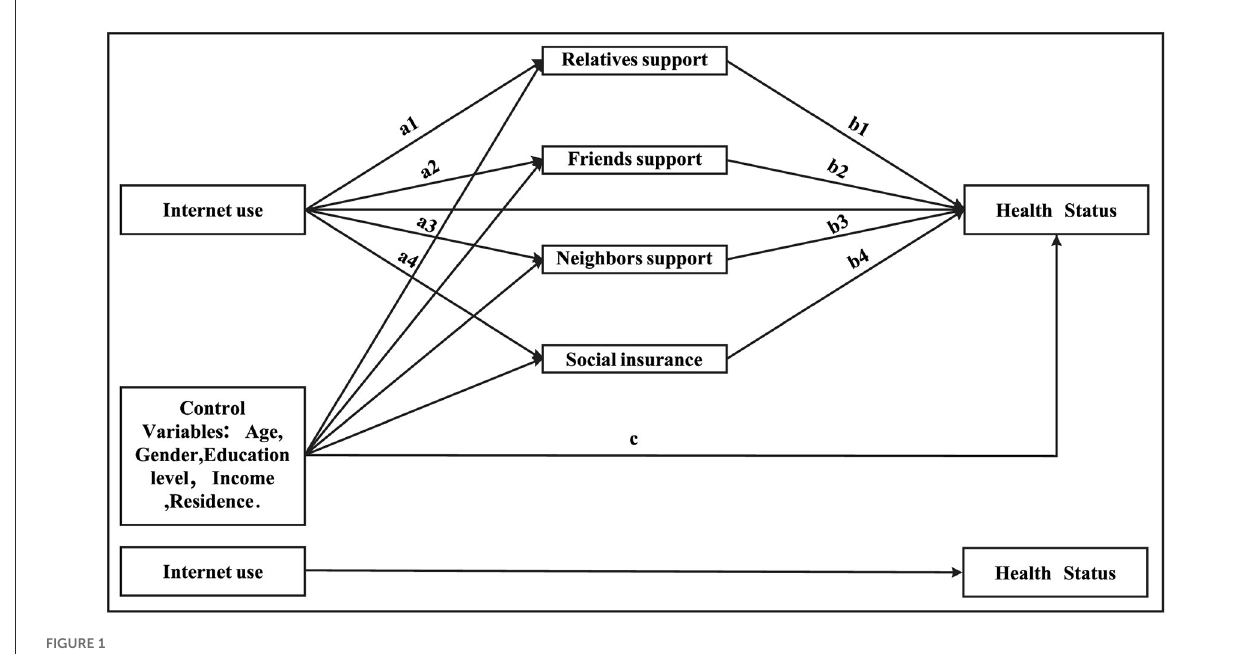
FIGURE1 The hypothesized